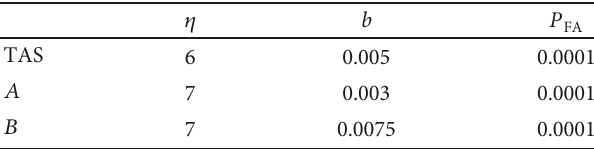
Table 7: Optimal design of the fl oating